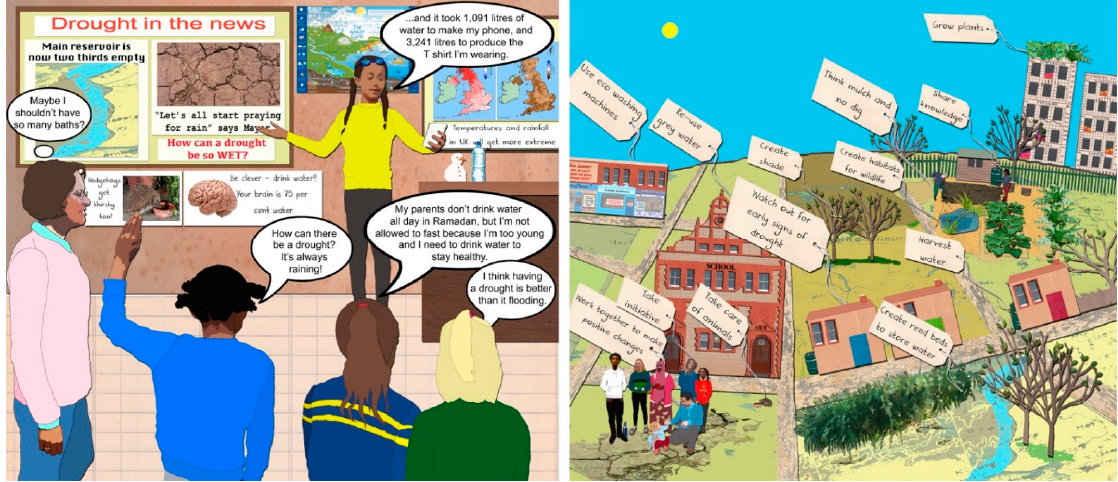
Figure 1. Two images from the DRY picture book (Luci Gorell Barnes, 2019, digital collage). The link to the full online book is given in the ‘Data availability Statement’ section.